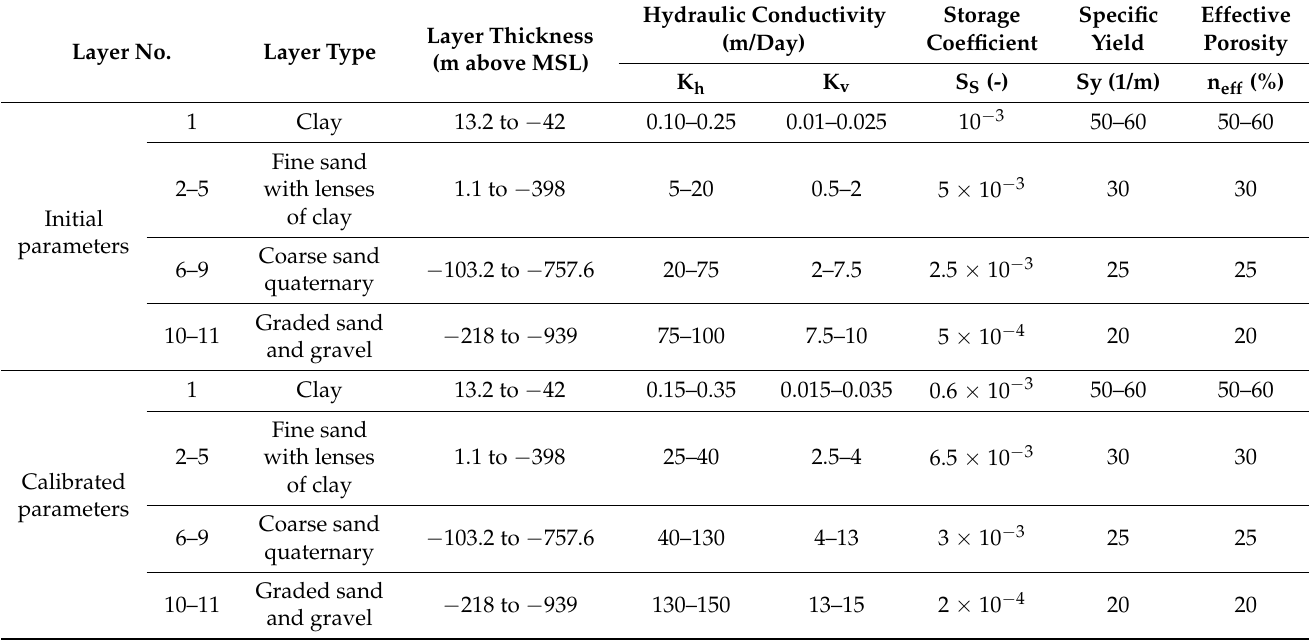
Table 3. Result of calibrated hydraulic parameters.